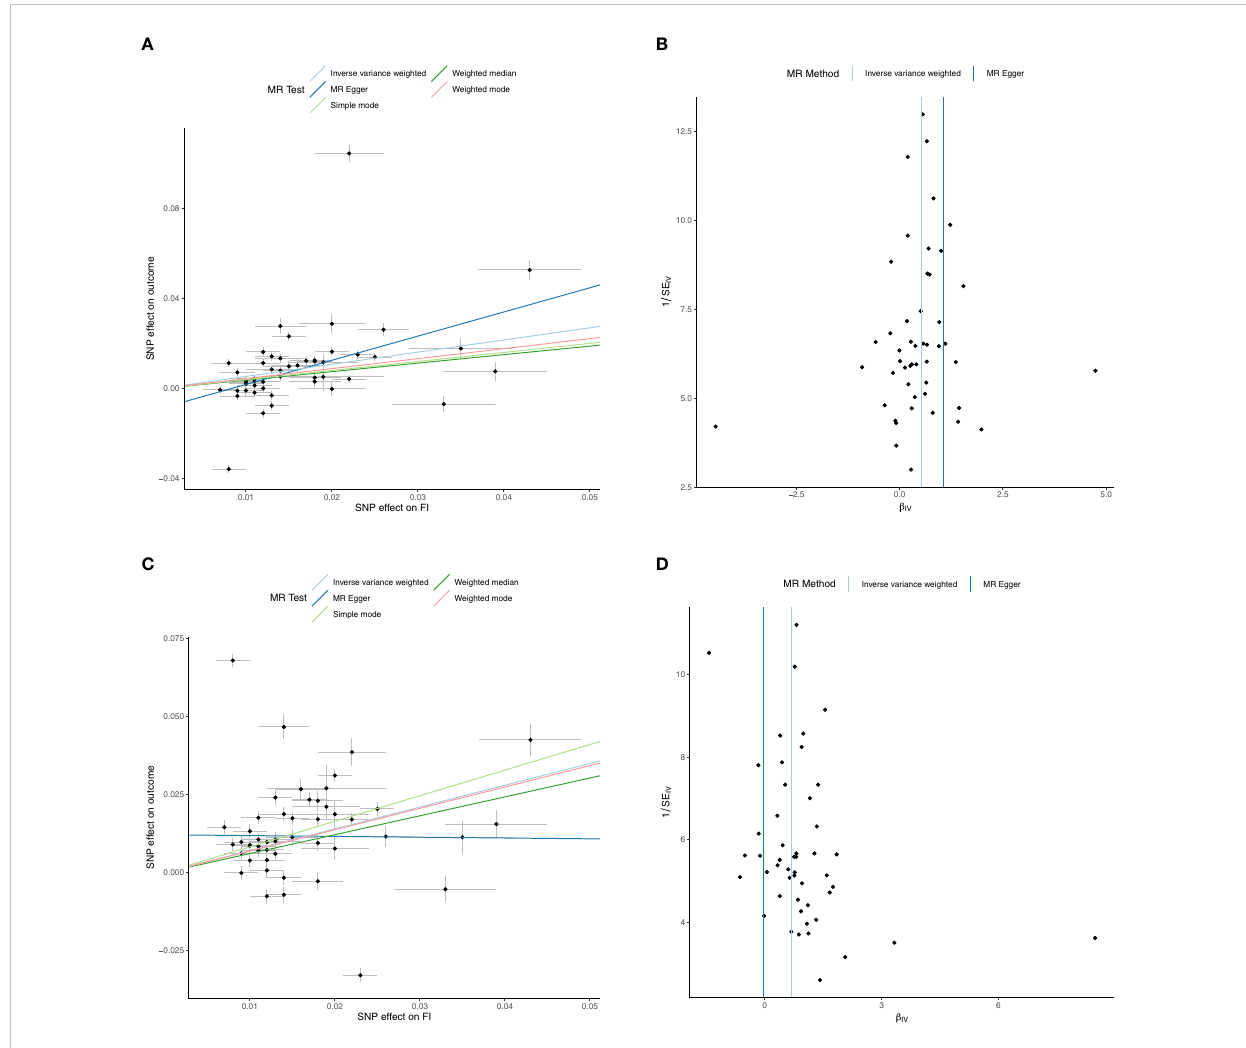
FIGURE 2 Univariable Mendelian Randomization (MR) Analysis — Exposure: fasting insulin (FI), Outcome: red cell count (RCC) and reticulocyte count (RETIC) — (A) Scatter plot showing the single nucleotide polymorphisms (SNPs) associated with FI against SNPs associated with RCC (vertical and horizontal black lines around points show 95% con fi dence intervals (CI) for fi ve different Mendelian Randomization (MR) association tests (B) Funnel plot of the effect size against the inverse of the standard error for each SNP for FI against RCC (C) Scatter plot showing the single nucleotide polymorphisms (SNPs) associated with FI against SNPs associated with RETIC (vertical and horizontal black lines around points show 95% con fi dence intervals (CI) for fi ve different Mendelian Randomization (MR) association tests (D) Funnel plot of the effect size against the inverse of the standard error for each SNP for FI against RETIC.